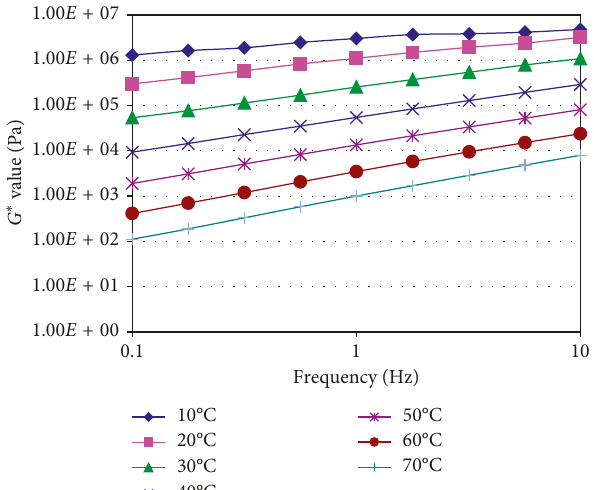
Figure 17: G value versus loading frequency for the stone sawdust mastic (VR 0.30). ∗ (cid:30) Table 8: Shift factors for the 0.05 stone sawdust-asphalt mastic. Temperature ( ° C)